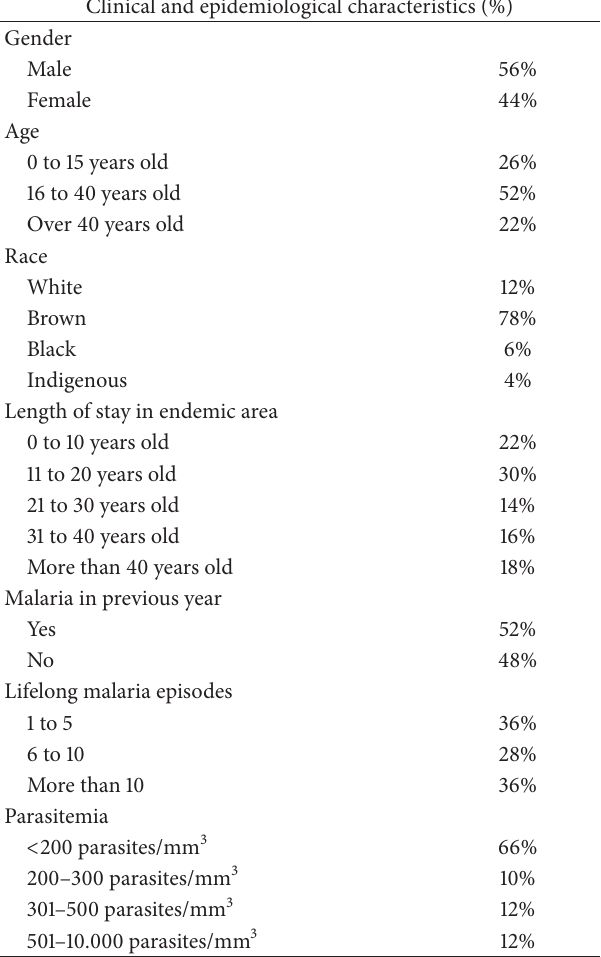
Table 1: Epidemiological and clinical variables of the study popula-